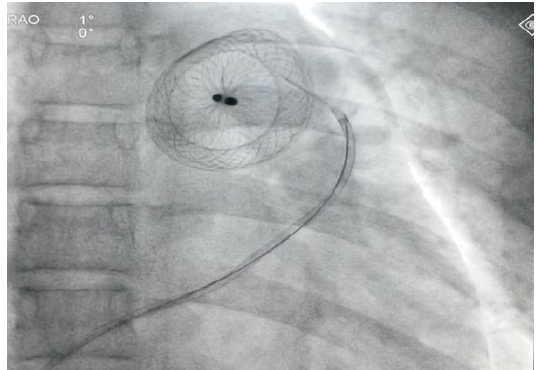
Figure 2. Removal of Amplatzer device from the right ventricular outflow tract branous and subaortic restrictive VSD (4